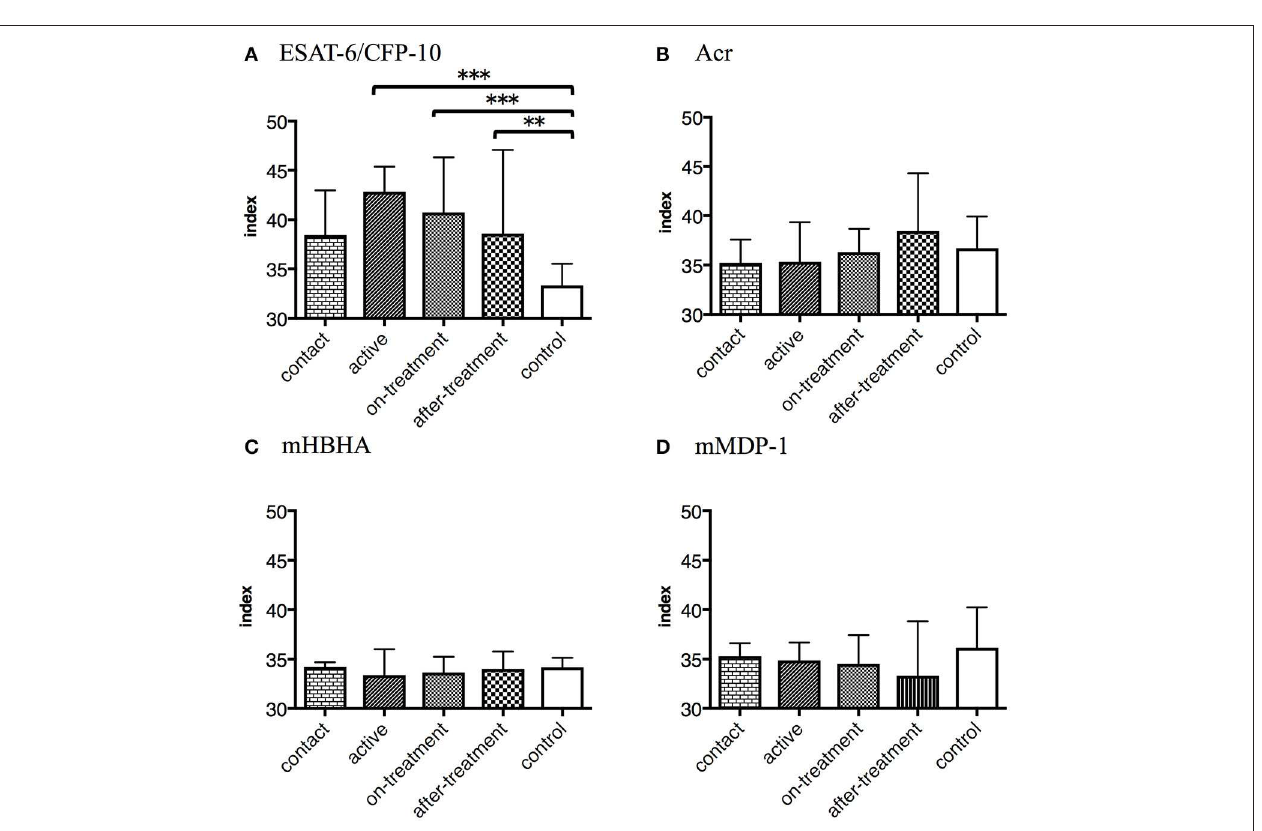
FIGURE 4 | The values represent polyfunctional index of M. tuberculosis -associated antigens in M. tuberculosis -infected cases, grouped according to the disease stage as active TB cases ( n = 24), on-treatment TB cases ( n = 24), after-treatment TB cases ( n = 19), and contact cases ( n = 15). The values of control cases ( n = 18) are also shown. Polyfunctional index of an object was calculated following an algorithm described previously ( 18). The differences between each set of samples were assessed using the Kruskal-Wallis test and post hoc Dunn’s Comparison test (** P < 0.01, *** P < 0.001). The bar represents the median, and the vertical line and horizontal bar represents the interquartile range. (A) Against ESAT-6/CFP-10. (B) Against Acr. (C) Against methylated (m) HBHA. (D) Against